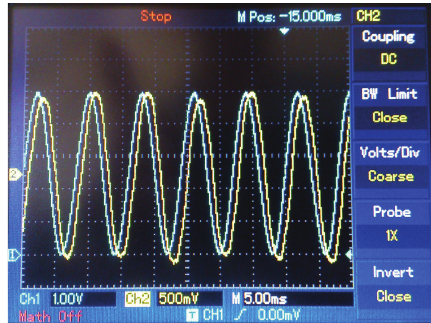
Figure 10: 125 Hz sine wave message. Blue: sent message. Yellow: retrieved message.